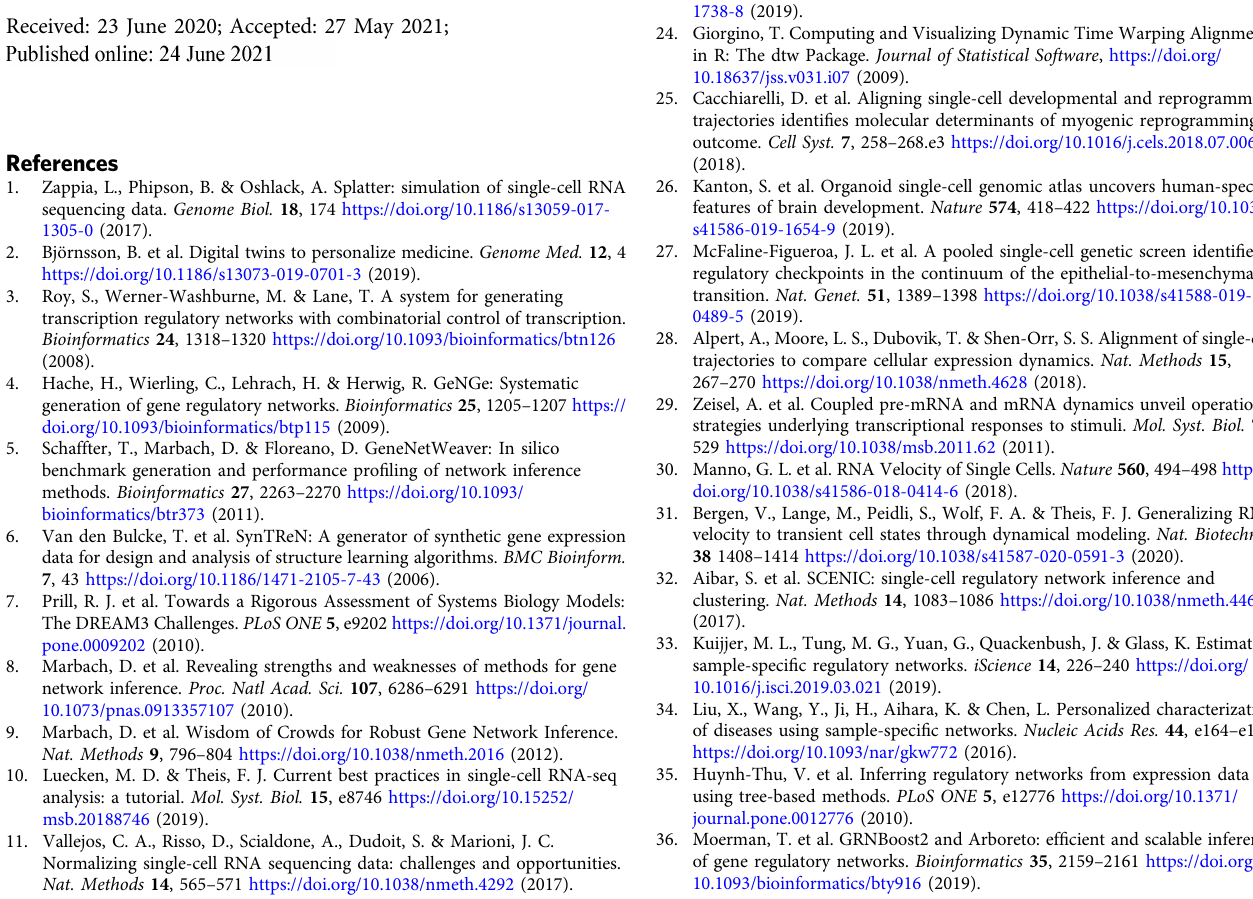
table 1.13.4, DBI 1.1.1, debugme 1.1.0, desc 1.2.0, digest 0.6.27, dplyr 1.0.5, dtw 1.22-3, dynparam 1.0.1, dynutils 1.0.6, dynwrap 1.2.2, ellipsis 0.3.1, fansi 0.4.2, farver